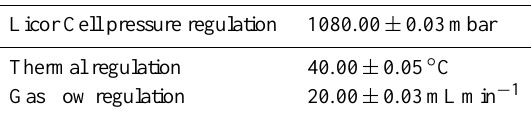
Table 1. Parameters of pressure, temperature and gas flow regula- tion for the CARIBOU CO 2